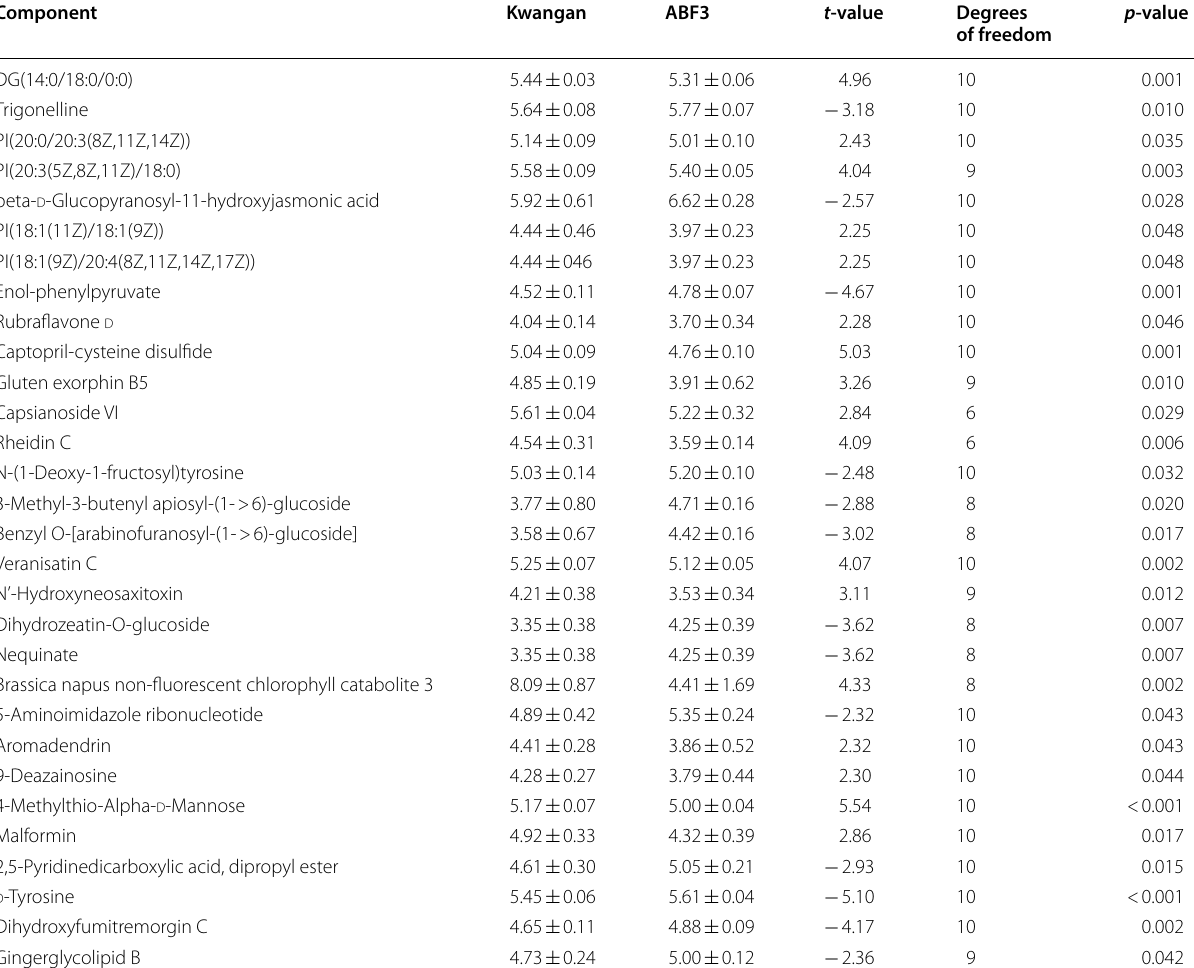
Table 3 Relative quantification of LC ‒ MS/MS-based metabolites in ‘Kwangan’ WT soybean and drought-tolerant transgenic soybean ‘ABF3’ measured after 9 weeks of moderate-drought treatment